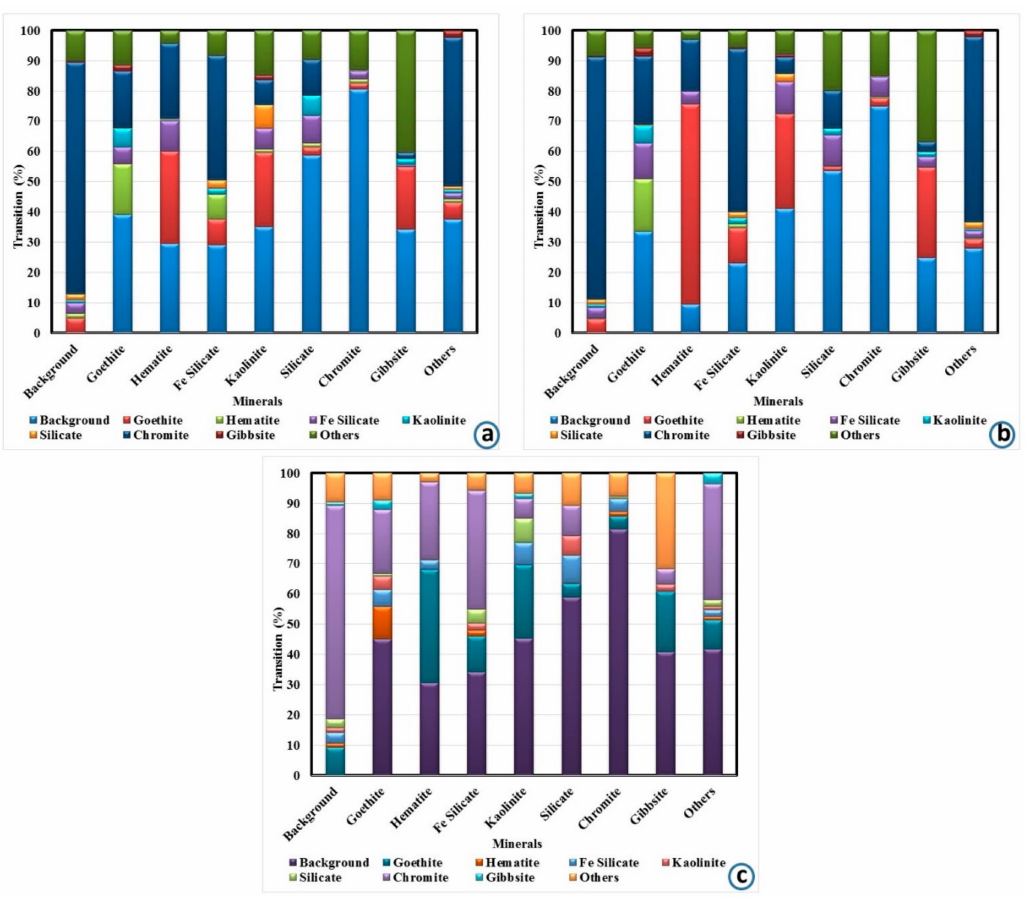
Figure 3. Association of di ff erent minerals in the chromite concentrate samples: ( a ) coarse, ( b ) fine, and ( c ) ultrafine concentrates.